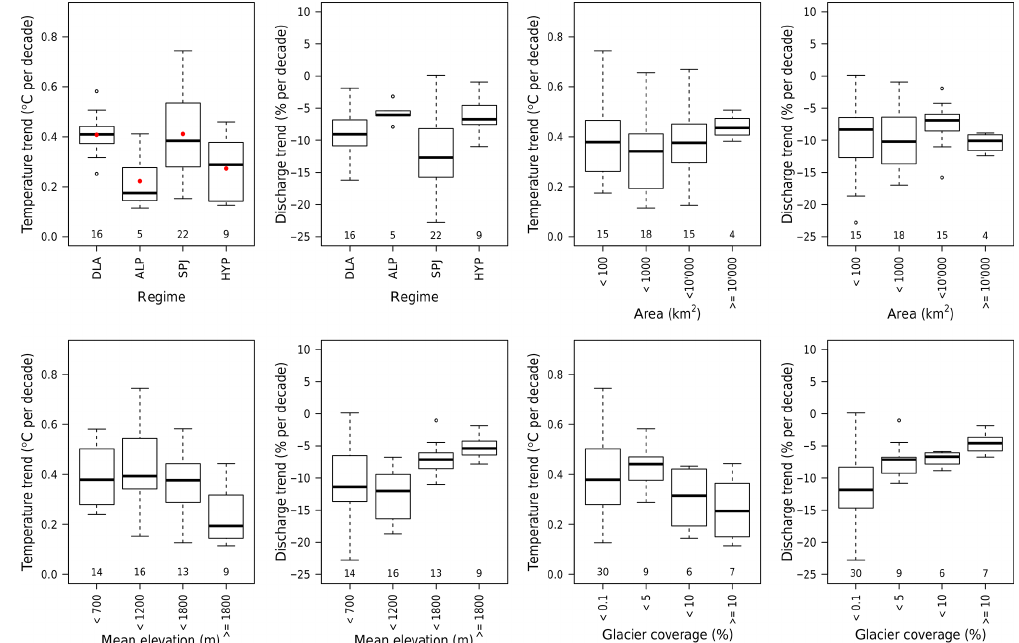
Figure 6. Water temperature and discharge trends for the 1999–2018 period classified by the four different hydrological regimes – down- stream lake regime (DLA), alpine regime (ALP), Swiss Plateau/Jura regime (SPJ), and strong influence from hydro-peaking (HYP) (top-left two panels); by the catchment area (top-right two panels); by the catchment mean elevation (bottom-left two panels); and by the glacier coverage (bottom-right two panels). The numbers along the bottom of the panels indicate the number of catchments in each category. In the top-left boxplot, the red dots are the mean values (values used for the Wilcoxon test, see text).